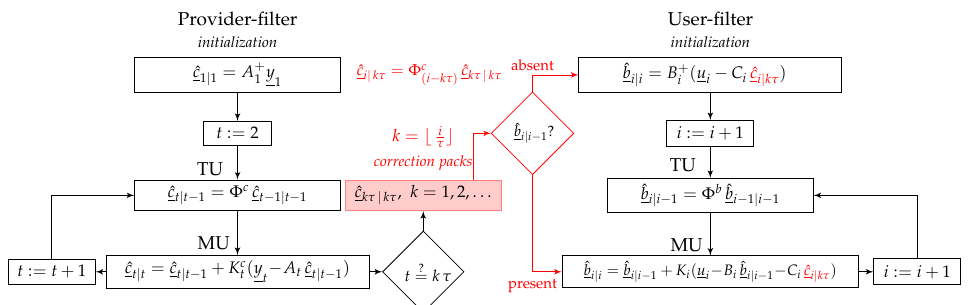
Figure 1. Double-filtering in PPP-RTK. ( Left ): the provider uses ‘time-uncorrelated’ observa- tion vectors y ( t = 0,1, . . . ) to generate and disseminate ‘time-correlated’ correction packs ˆ c ( k = 1,2, . . . ) every τ seconds. ( Right ): the user picks the ‘most recent’ correction pack ˆ c k τ k τ | to feed their model at epoch i . Thus, k = less than or equal to x . If no previous user solution ˆ b i with the corrected observation vector u i MU step.